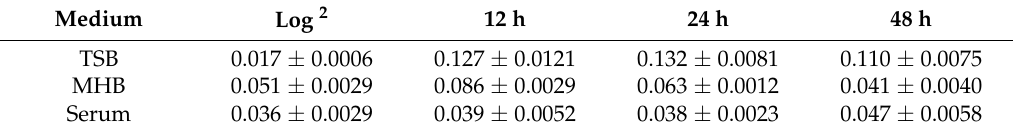
Table 2. Carotenoid content 1 (OD 465 /mg of dry cell mass) of Pig1 grown in various